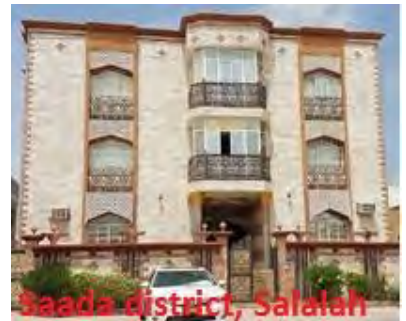
Figure 18. Fac¸ade’s photograph building location